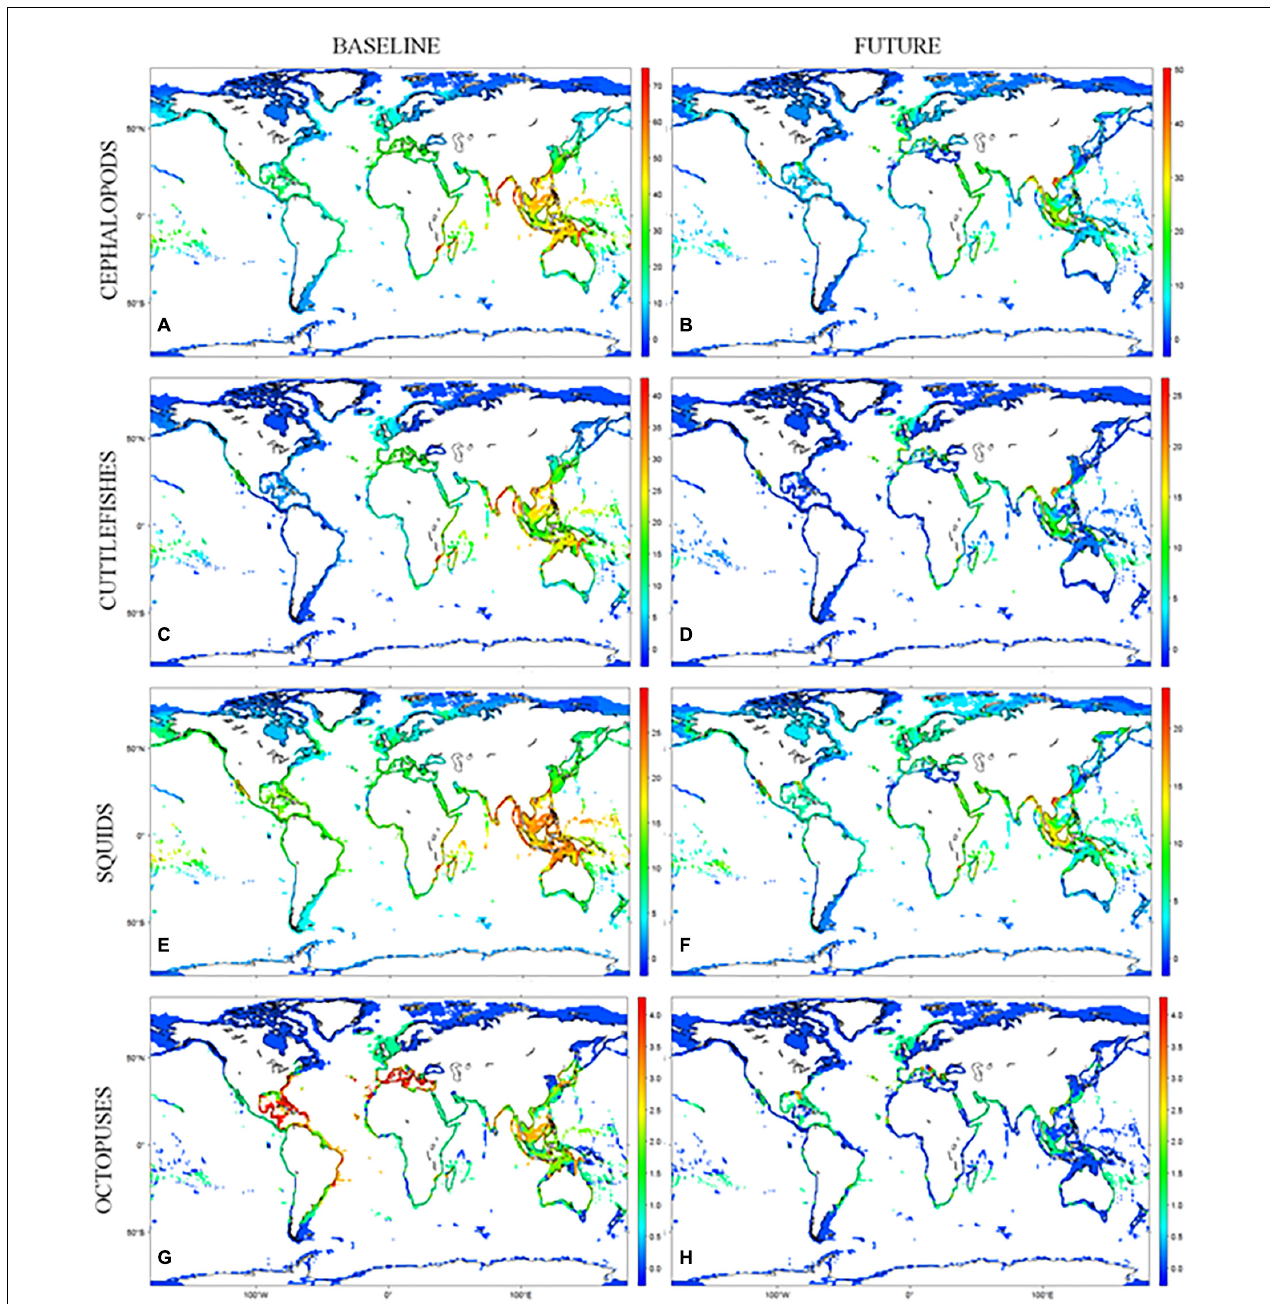
FIGURE 1 | (A–H) Projected richness for the baseline and the end-of-century period, under IPCC AR5 RCP4.5 scenario, for coastal cephalopods and its main groups [cuttlefishes ( n = 76), squids ( n = 69), and octopuses ( n = 11)]. in 100% of the species are projected to reduce geographic range (with 30% projected to completely lose adequate